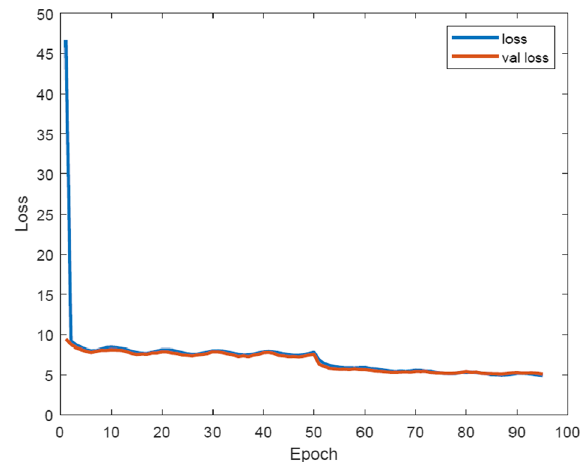
Fig. 10 Network model training